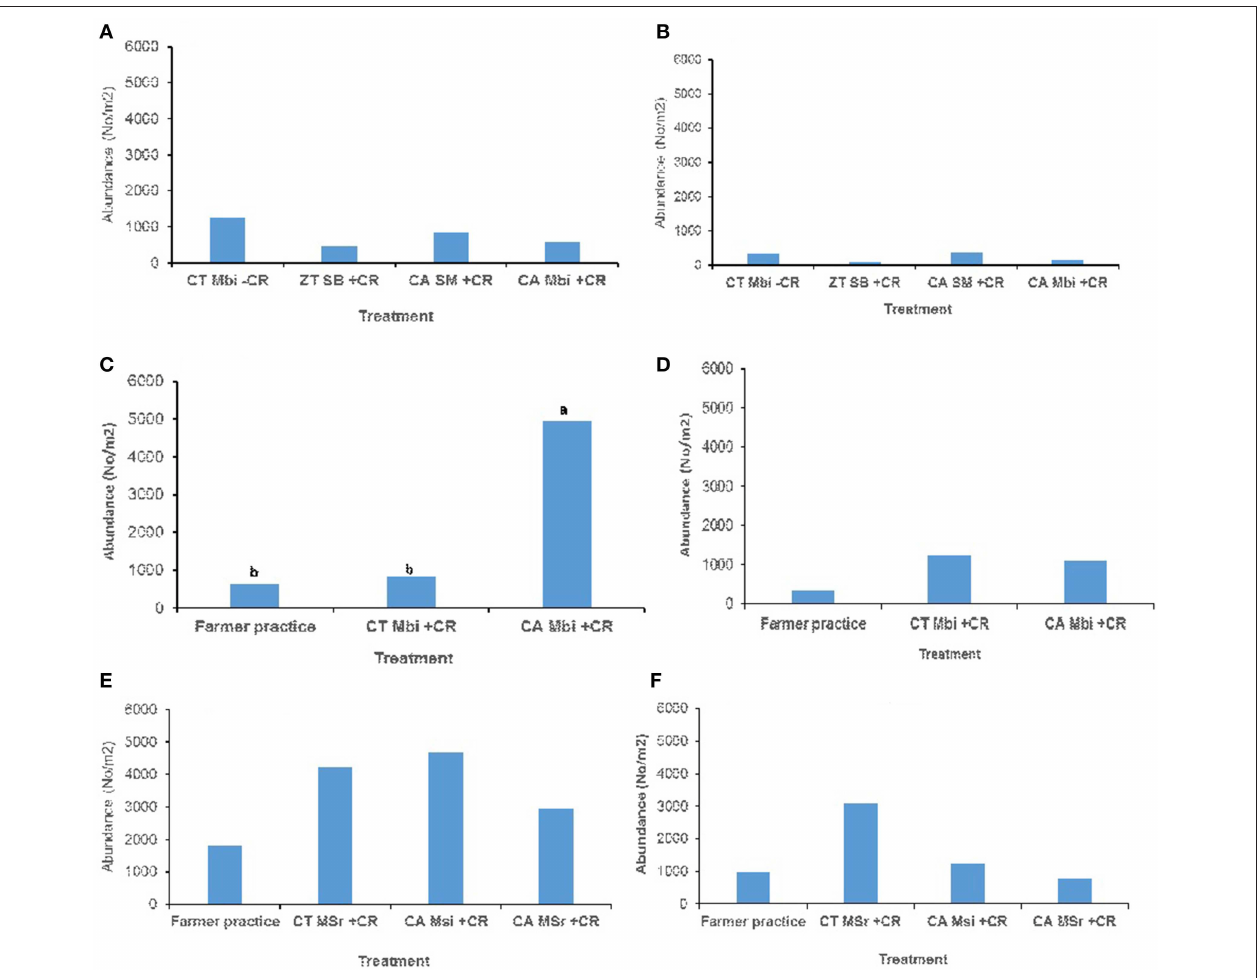
FIGURE 4 | Soil mesofauna abundance across trials of Embu, Kakamega, and Nyabeda. MT, Medium-term; LT, Long-term; CT, Conventional till; CA, Conservation agriculture (Zero till); SM, Sole maize; SB, Sole beans; MBi, Maize bean intercrop; MSi, Maize-soybean intercrop; MSr, Maize-soybean rotation; CR, Crop residue. (A) Embu MT (0-15 cm, p = 0.664); (B) Embu MT (15-30 cm, p = 0.233); (C) Kakamega MT (0-15 cm, p = 0.036*); (D) Kakamega MT (15-30 cm, p = 0.347); (E) Nyabeda LT (0-15 cm, p = 0.425); (F) Nyabeda LT (15-30 cm, p = 0.256). Bars with different lower case letters are statistically significantly different at p <